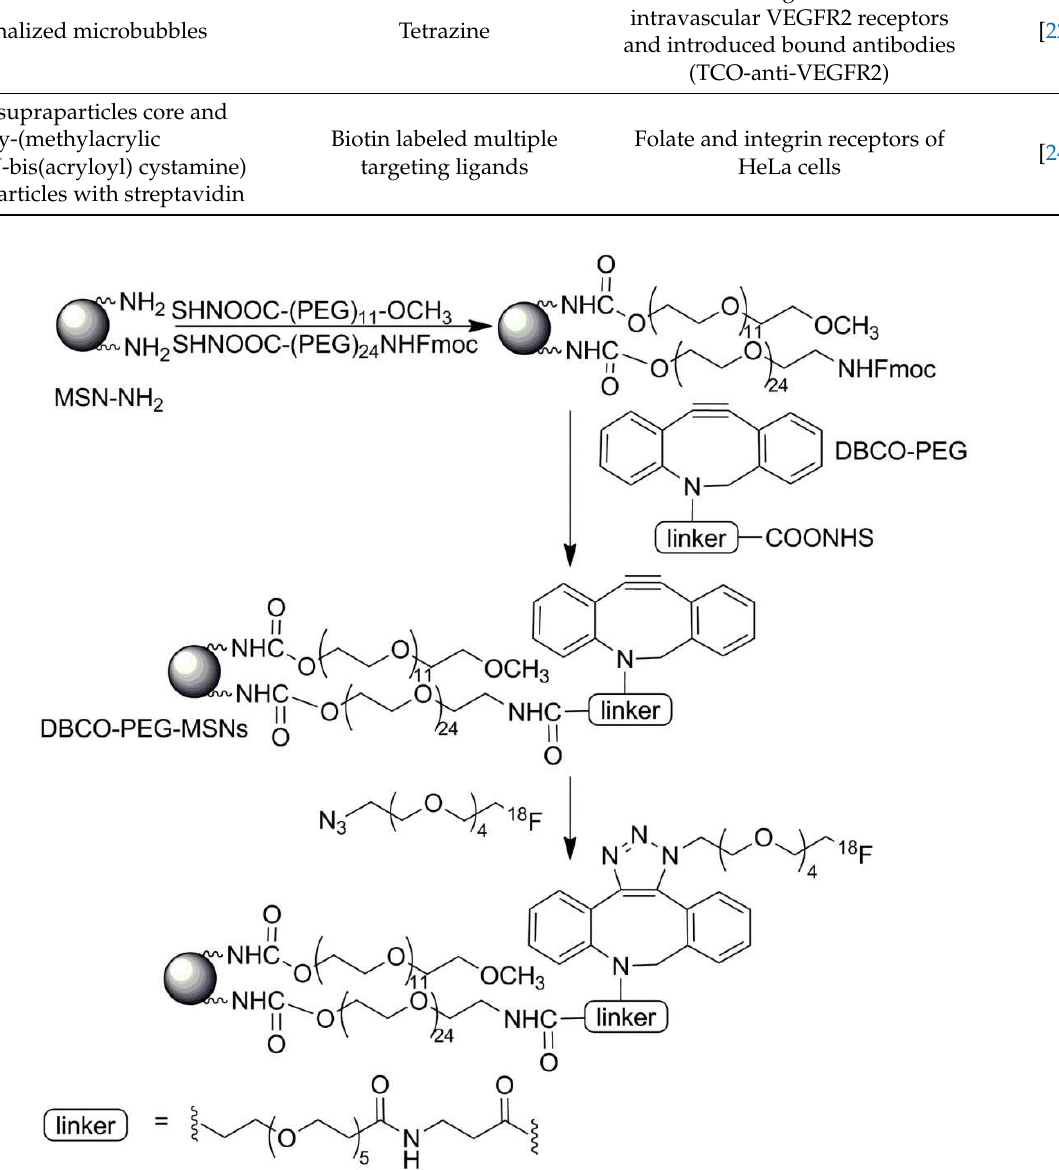
Table 2. Examples of particles carrying attached ligand(s) binding to receptors of targeted